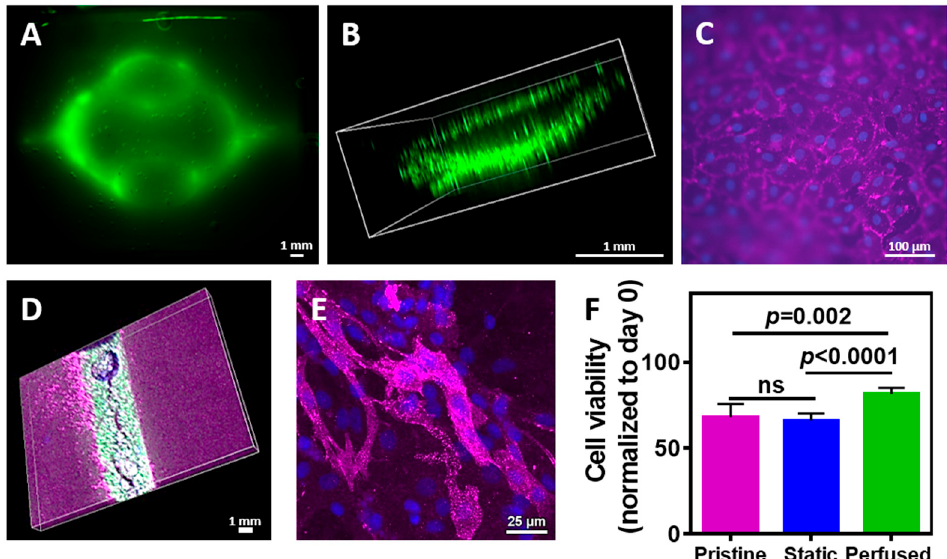
Figure 6. Cells within the patterned hydrogel. ( A ) GFP-expressing endothelial cells were attached to the hydrogel channels. ( B ) Confocal image of a lumen composed from the seeded endothelial cells. ( C ) Endothelial cell layer on the channel wall (pink: CD31, blue: nuclei). ( D ) Co culture of endothelial cells seeded in the channel and cardiac cells in the bulk. ( E ) Cardiac cell assembly in the omentum-based hydrogel (pink: cardiac sarcomeric actinin, blue: nuclei). ( F ) Viability of cardiac cells in pristine hydrogel and vascularized hydrogels with and without perfusion.